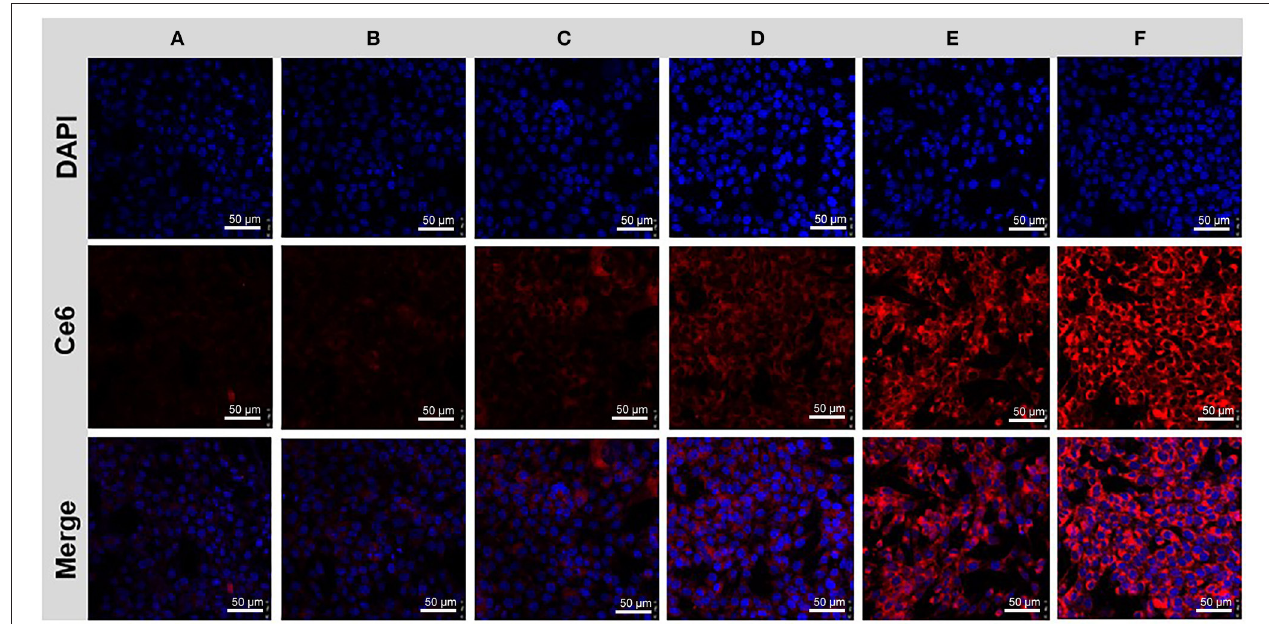
FIGURE 4 | Cancer cell uptake assay. Cells treated with free Ce6 for 2h (A) , 6h (C) , 10h (E) ; and BSA@HA-sese-Ce6@CYC for 2h (B) , 6h (D) , 10h (F) .